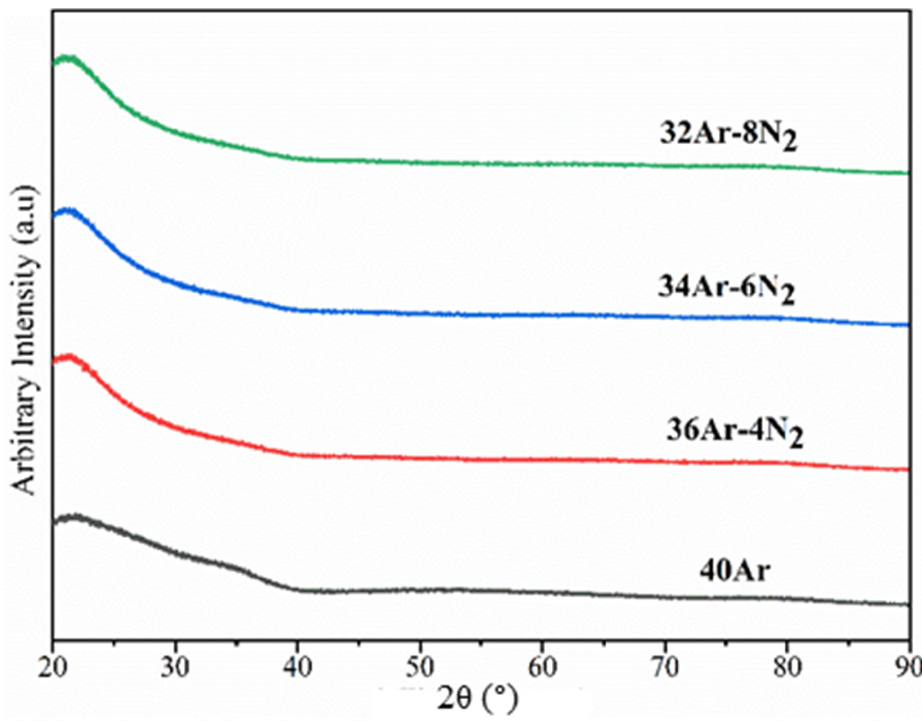
Figure 1. XRD spectra of Ta 2 O 5 coatings deposited at a sputtering power of 140 W with different N 2 and Ar fluxes.